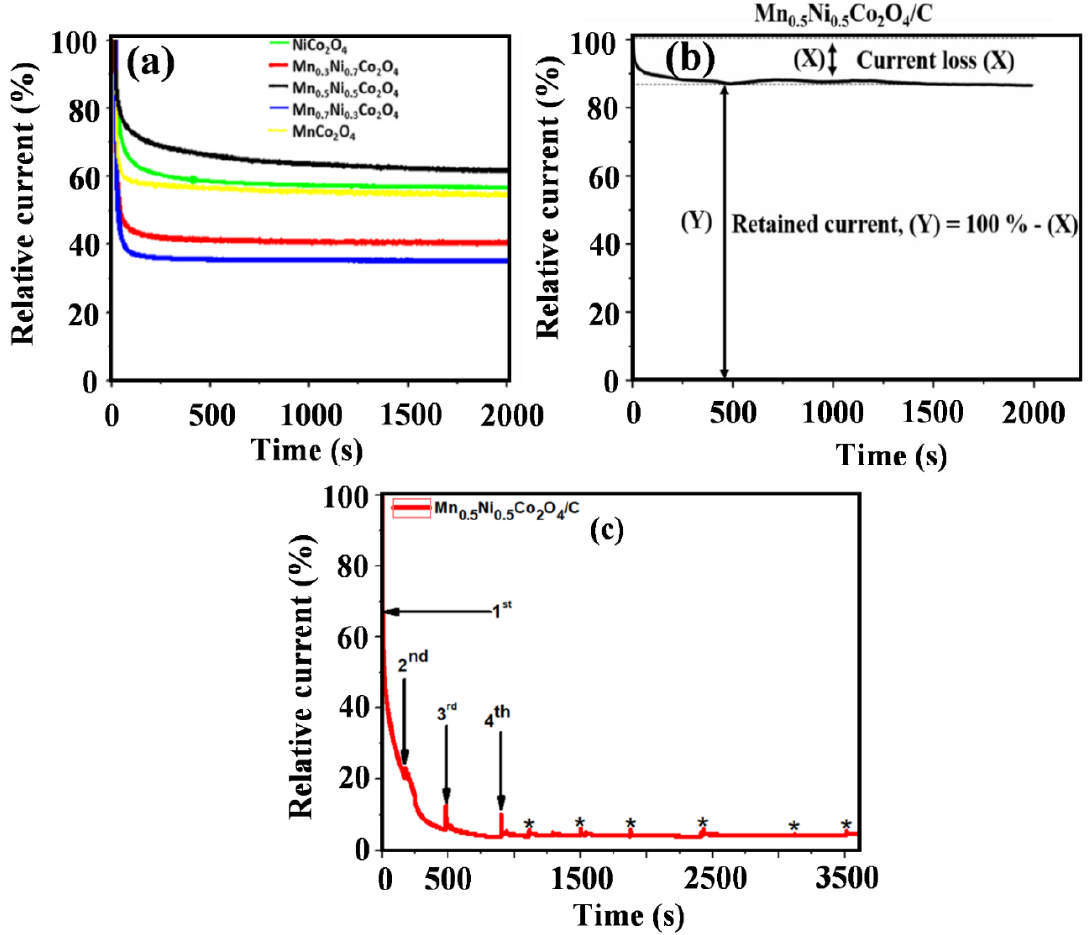
Figure 9. Chronoamperometric detection of ( a ) Mn x Ni 1 − x Co 2 O 4 spinel series, ( b ) Mn 0.5 Ni 0.5 Co 2 O 4 /C, and ( c ) poisoning studies of Mn 0.5 Ni 0.5 Co 2 O 4 /C in O 2 -saturated 0.1 M KOH at 1.2 (V vs. RHE).